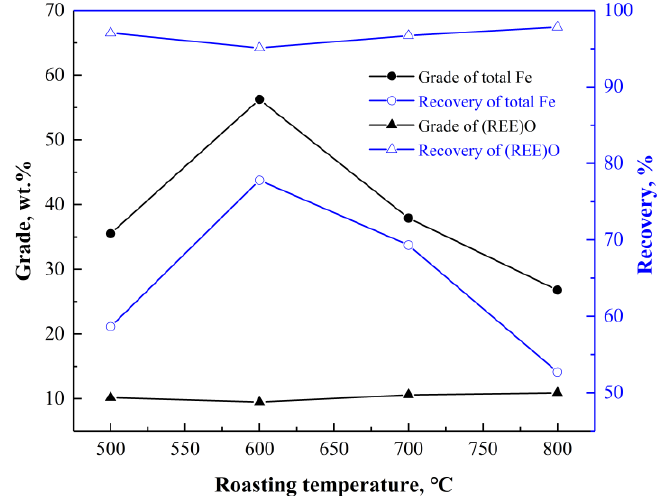
Figure 11. Grade and recovery of total Fe and (REE)O in the magnetic separation concentrate and tailings.